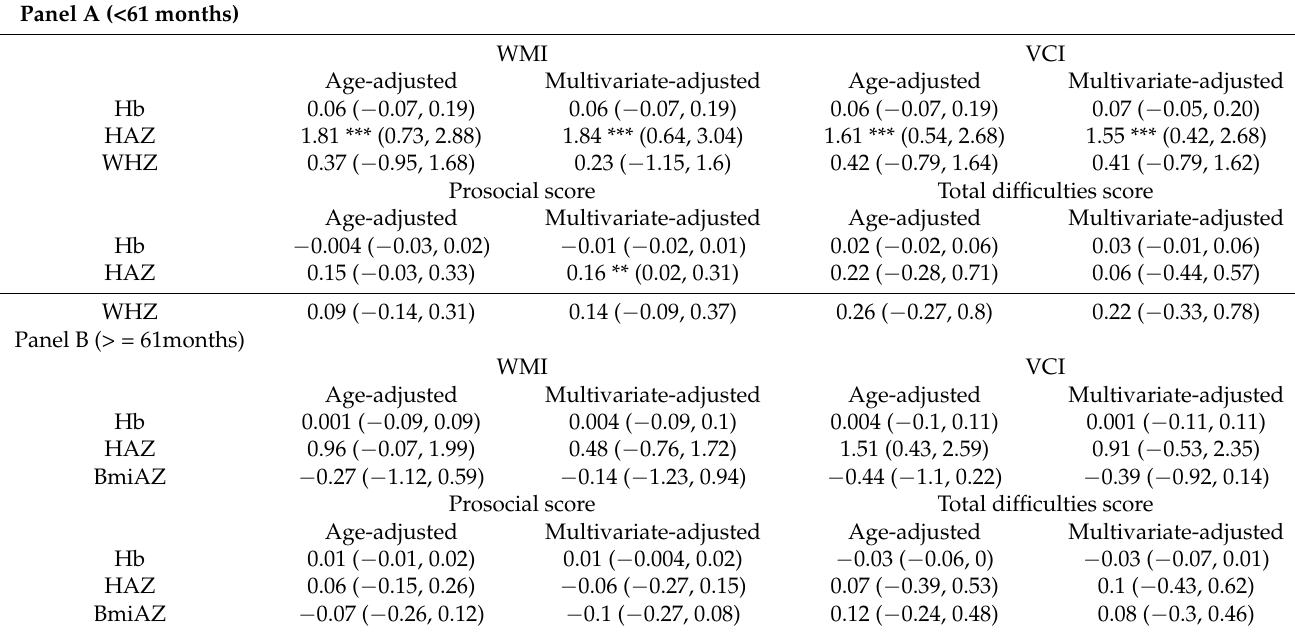
Table A2. Cross-sectional associations among Hb, HAZ, WHZ, and child cognitive outcomes for children younger than 61 months of age. Values are coefficient (95%